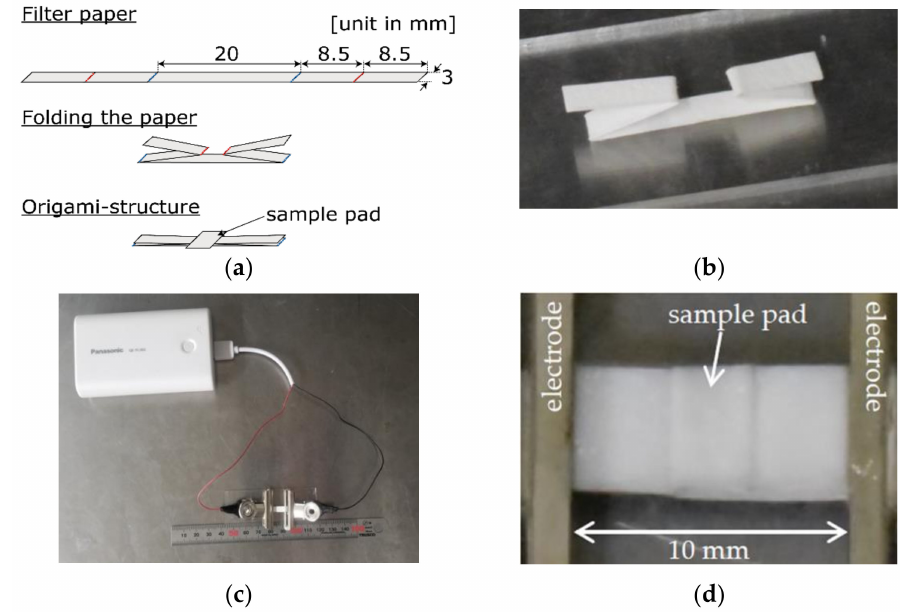
Figure 1. Proposed paper-based analytical device (PAD) device. ( a ) How to make the proposed origami structure. A sample pad was put on the center of the folded paper. ( b ) Photograph of the origami structure. ( c ) The origami PAD connected to a portable power bank. ( d ) Close-up photograph of the PAD. Bulldog clips were used as